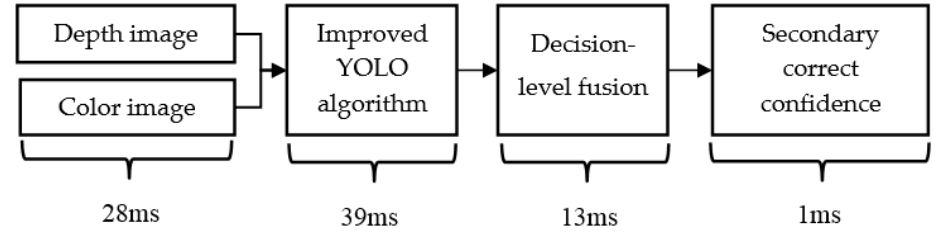
Figure 7. Processing time for each step of the inspection system (in ms).